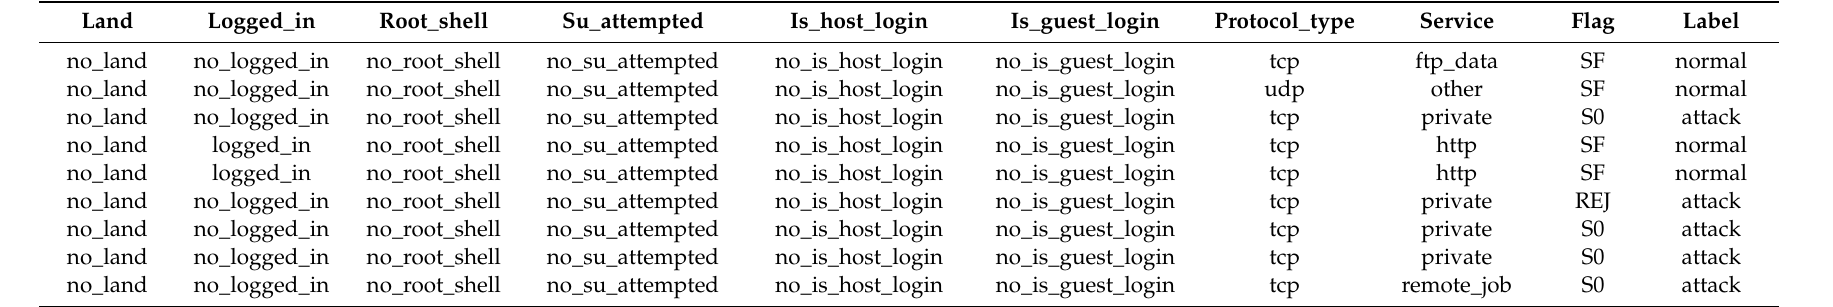
Table 4. The results of data preprocessing corresponding to the Apriori algorithm.